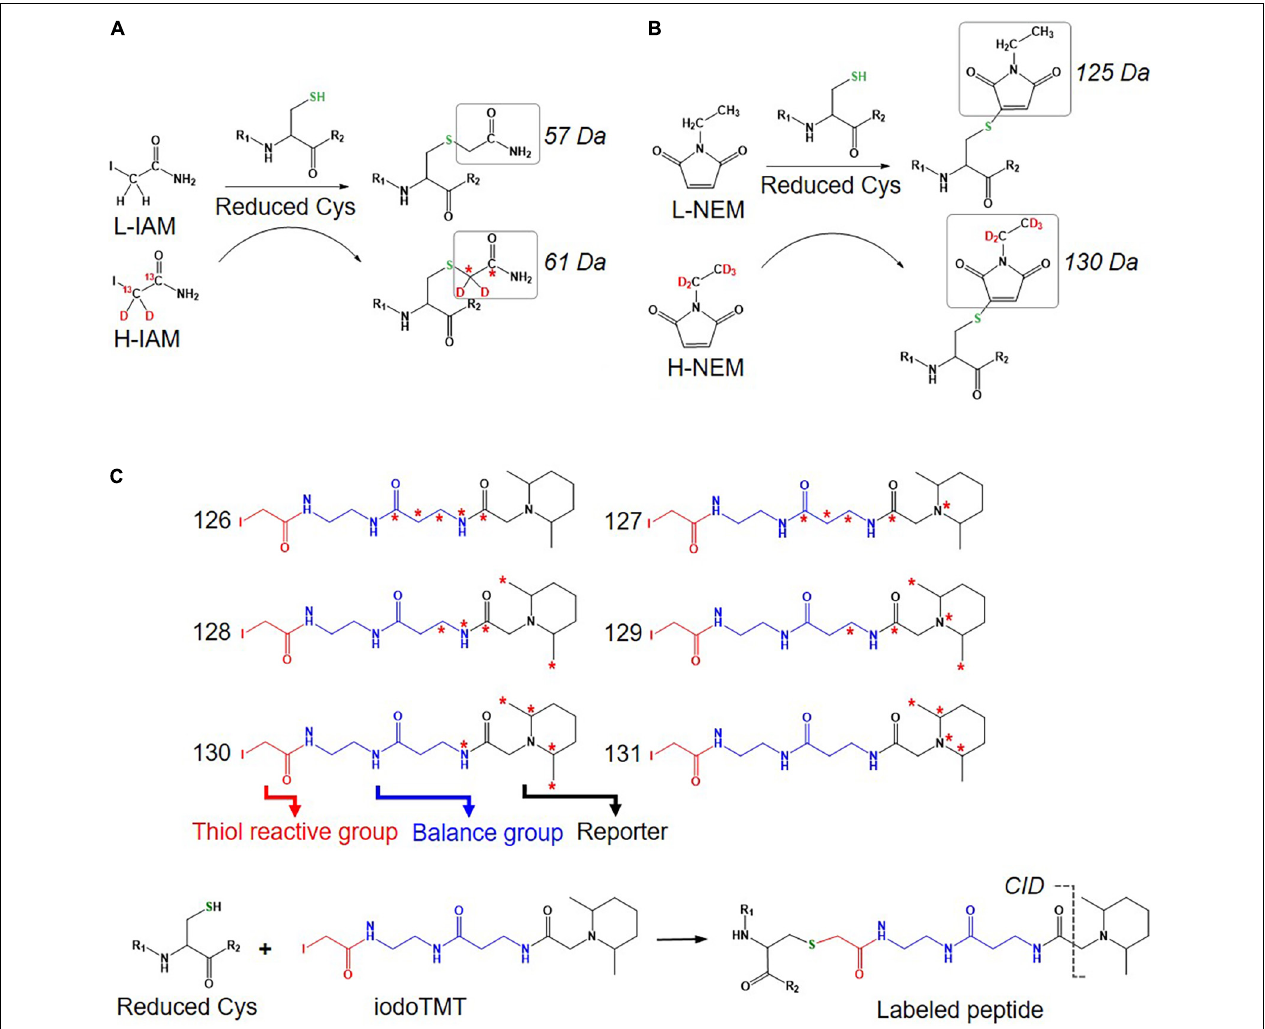
FIGURE 4 | Isotope labeled reagents and probes used for Oxi-Cys proteomics. Isotopic chemicals and their adding extra mass for PTM search: (A) L-IAM and H-IAM, (B) L-NEM, and H-NEM, (C) iodoTMT reagents and the cleavage site to release ion reporters by CID during MS/MS